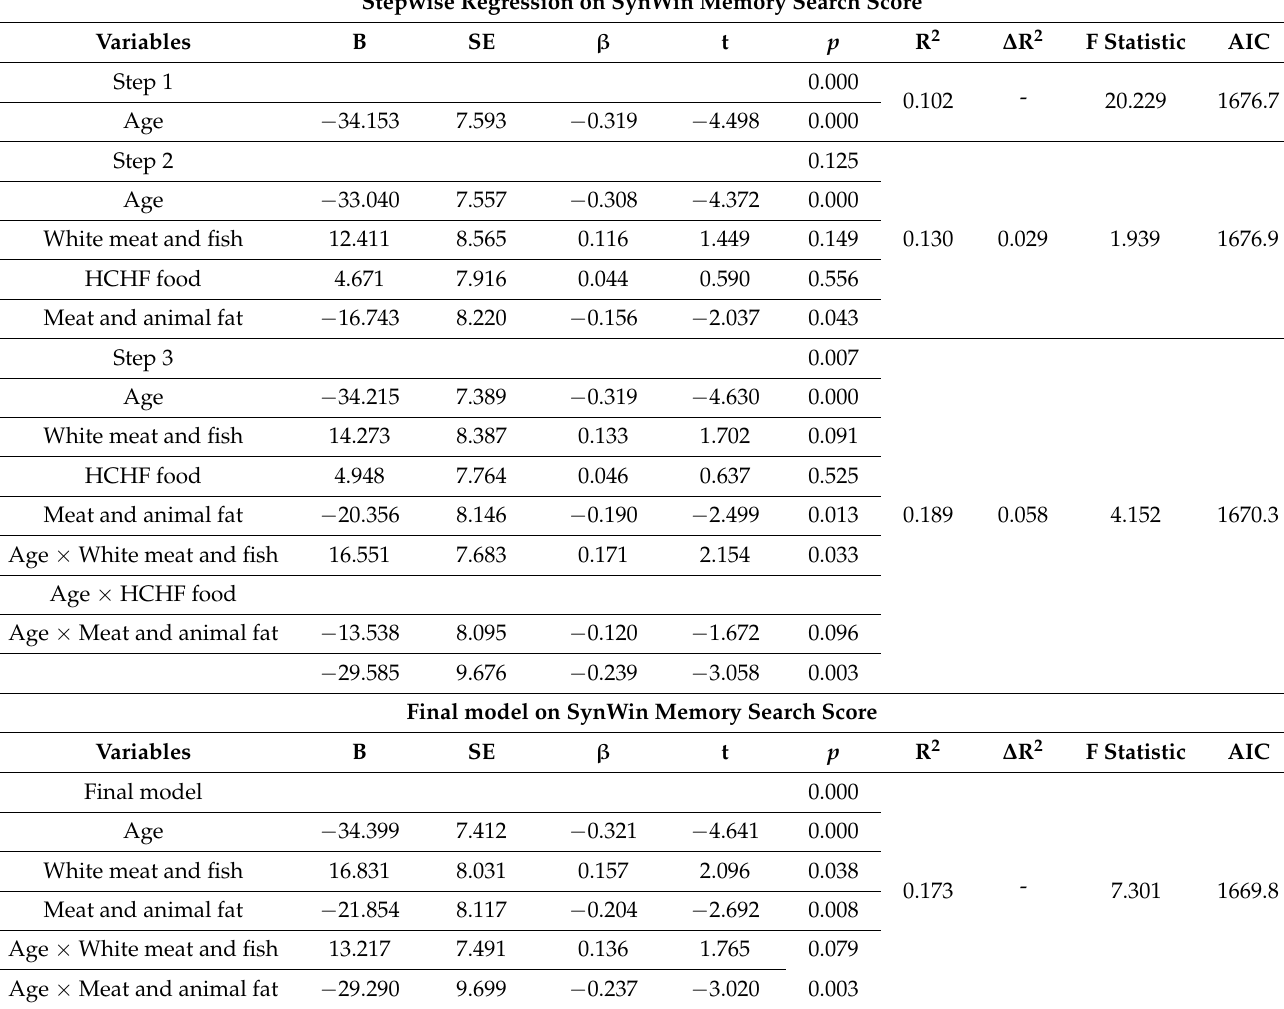
Table 7. Summary of linear stepwise regression analysis for various consumption patterns predicting the impact on SynWin memory search performance for all participants ( n =